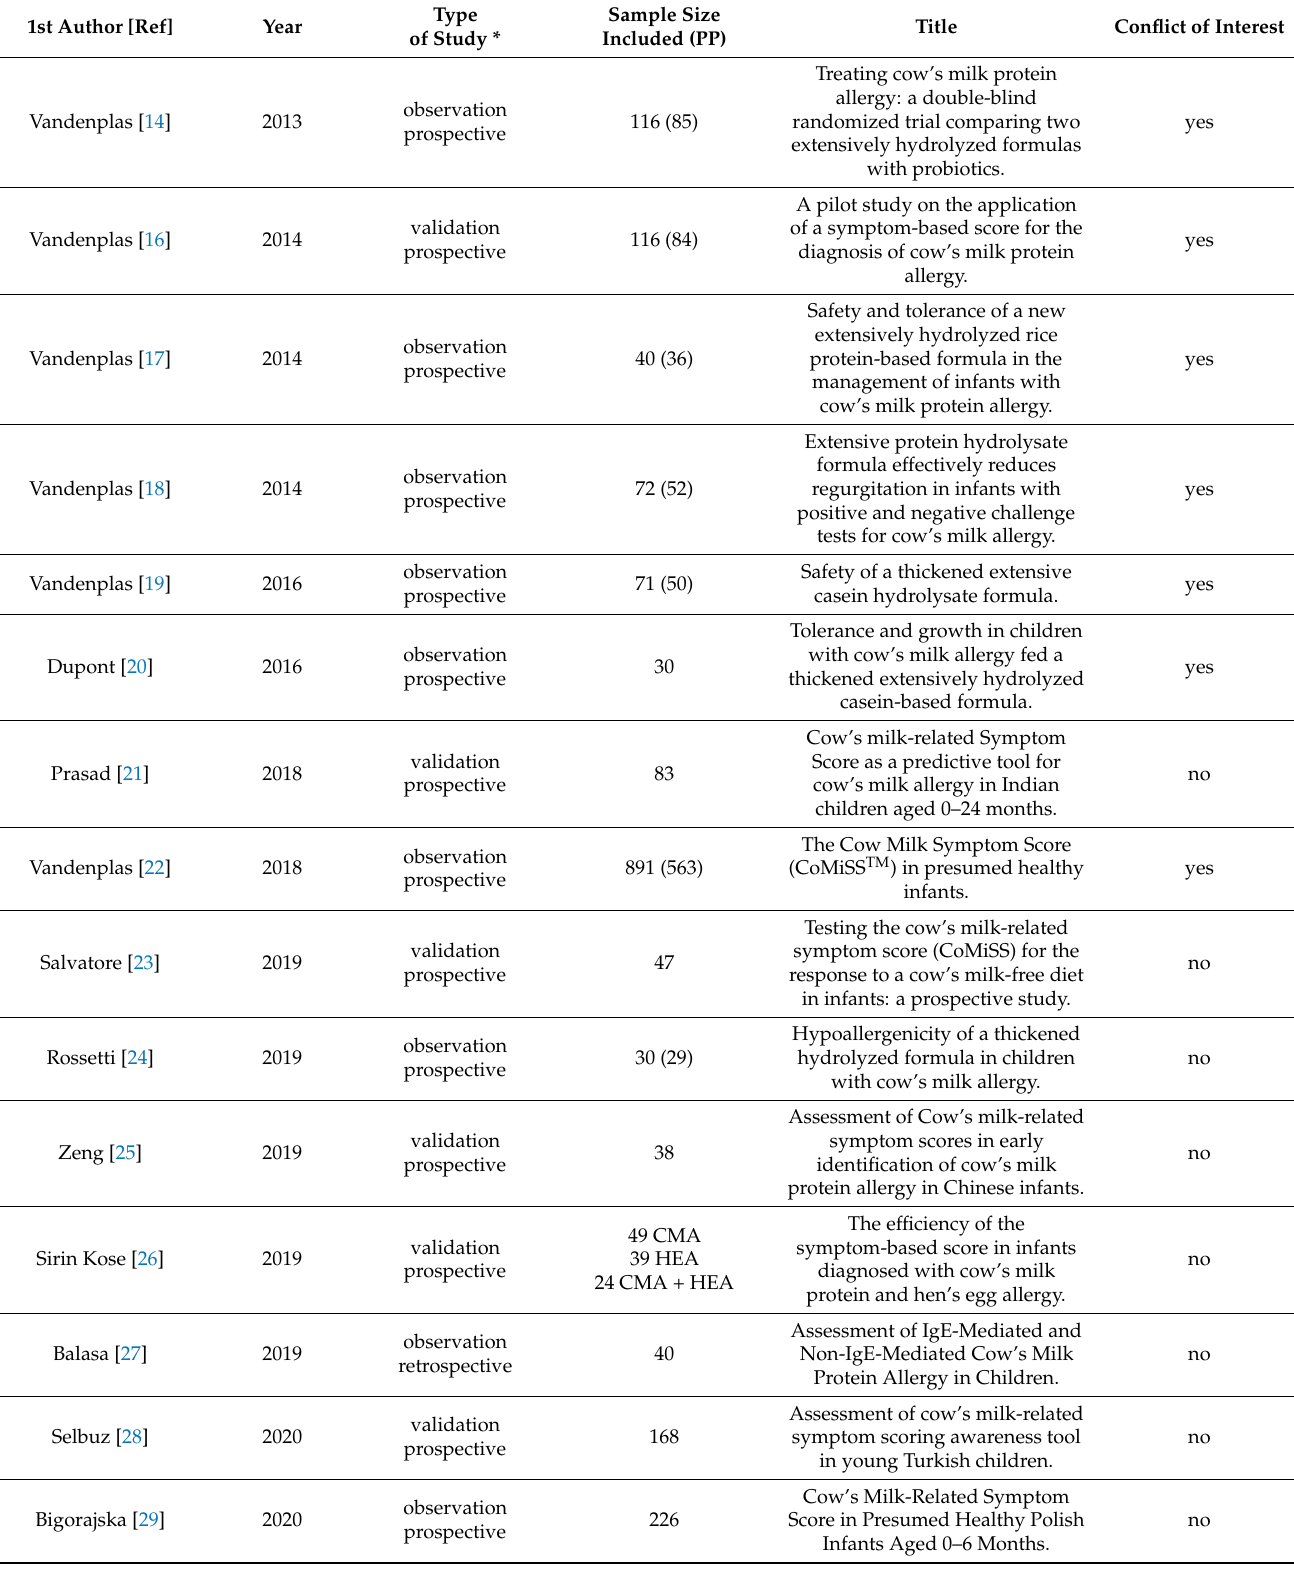
Table 2. Included